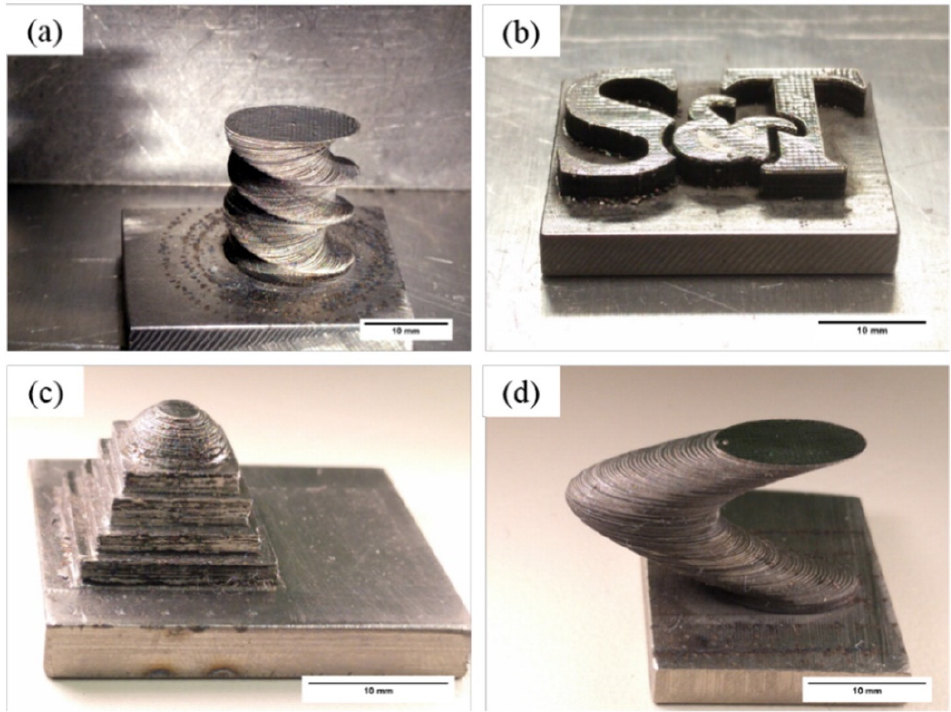
Figure 10. BMG parts fabricated via LFP with different geometries. Reproduced from [109], with permission from Elsevier, 2021.